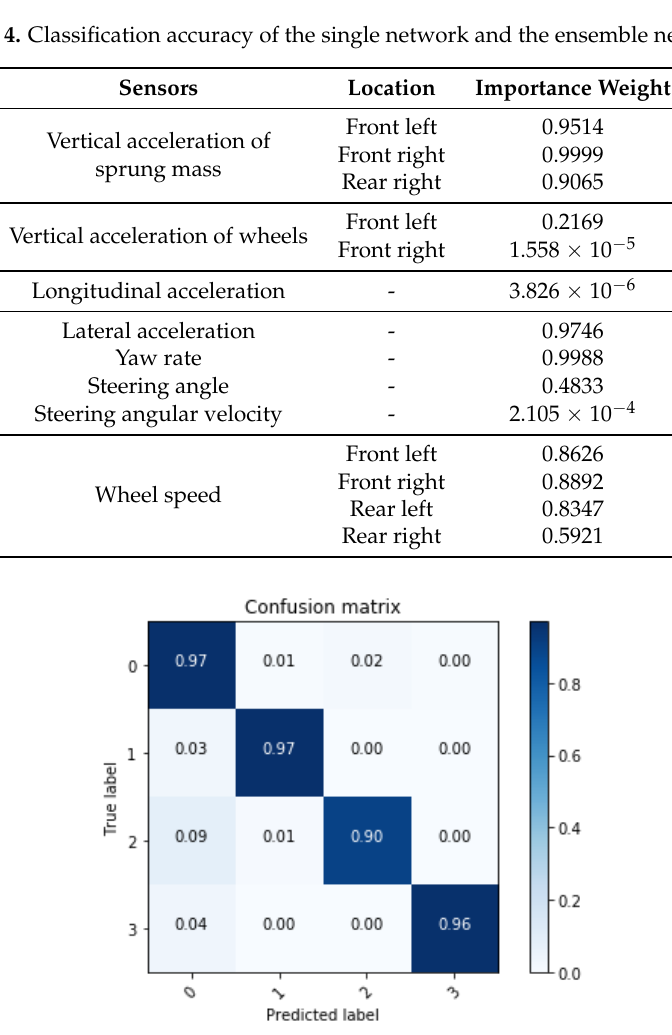
Figure 12. Confusion matrix after feature